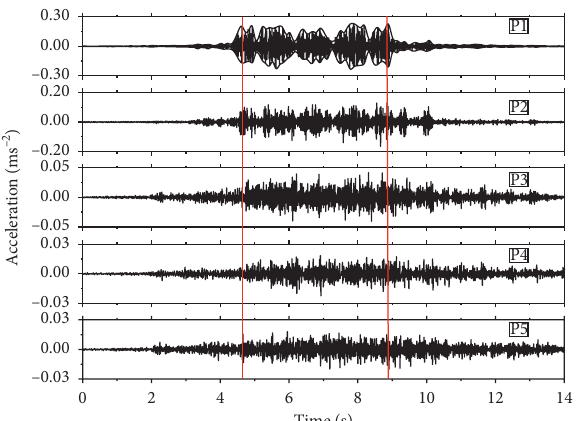
Figure 6: Measured acceleration time histories at the 5 points, recorded at 7: 27 am on March 6, 2007.